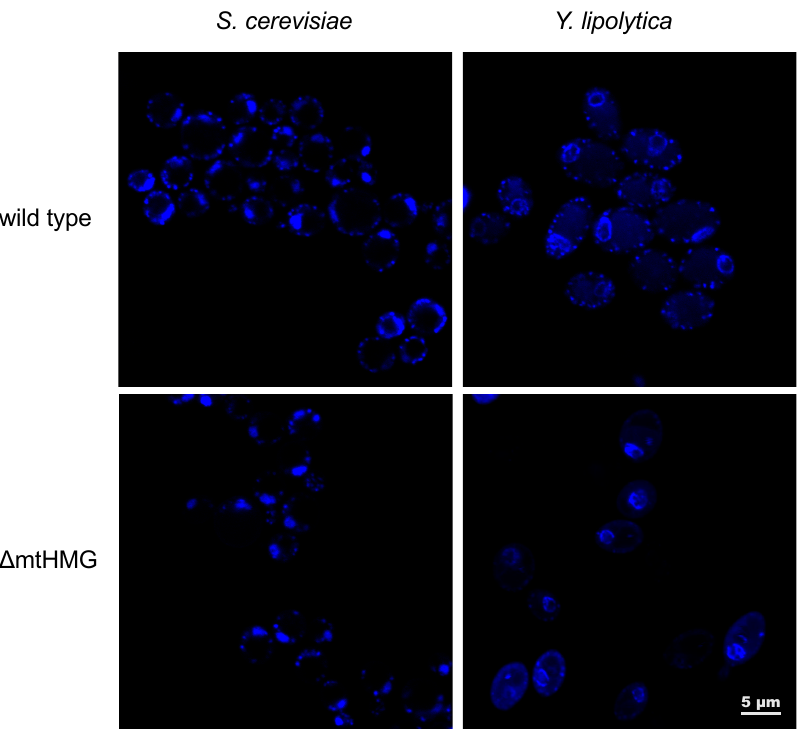
Figure 2. Visualization of DNA in wild-type cells vs. mutants lacking mtHMG protein ( ∆ mtHMG). Nuclear DNA (large blue dots) and mt-nucleoids (smaller blue spots) were visualized in yeast cells using confocal microscopy (Olympus IX81) after DAPI staining. As in the S. cerevisiae abf2 - mutant, the deletion of mtHMG genes in Y. lipolytica, a strictly aerobic yeast, resulted in a decreased number of mt-nucleoids.